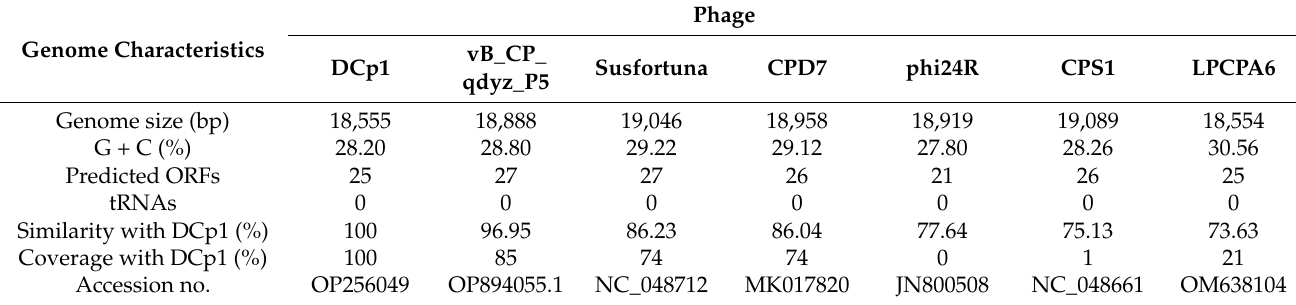
Table 1. Comparison of general genomic features of phage DCp1 and other closely related phages.